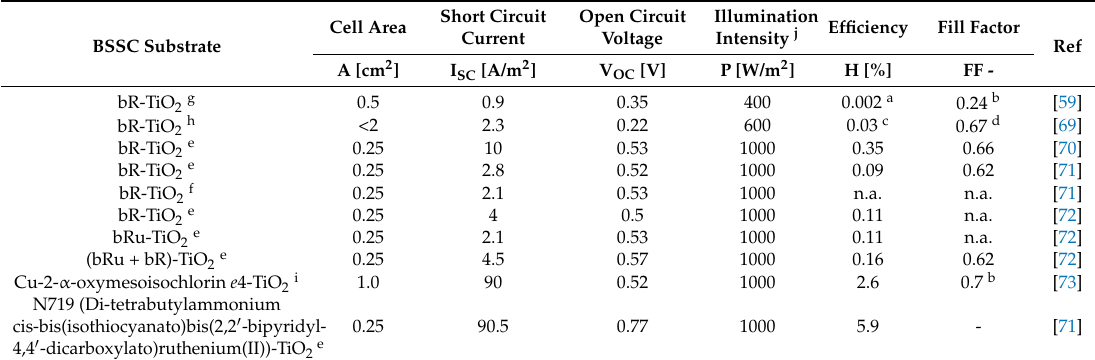
a : calculated from Figure 11 in [59] using a linear approximation of the V Figure 11 in [69]. e : with Pt-coated FTO glass as counter electrode. f : with C-coated FTO glass as counter electrode. g : with Al-coated FTO glass as counter electrode. h : nanotube arrays. i : Pt as counter electrode. j : white light illumination. 1 : Table 1 is by no means exhaustive, but serves to provide exemplary values for I SC , V OC , FF, and η in biomimetic systems allowing for direct comparison with conventional photovoltaic